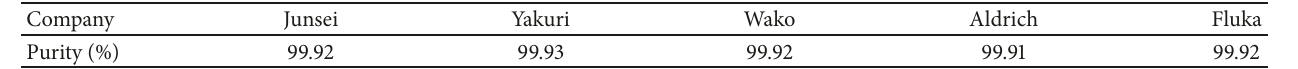
Table 3: Purities of commercial titanium